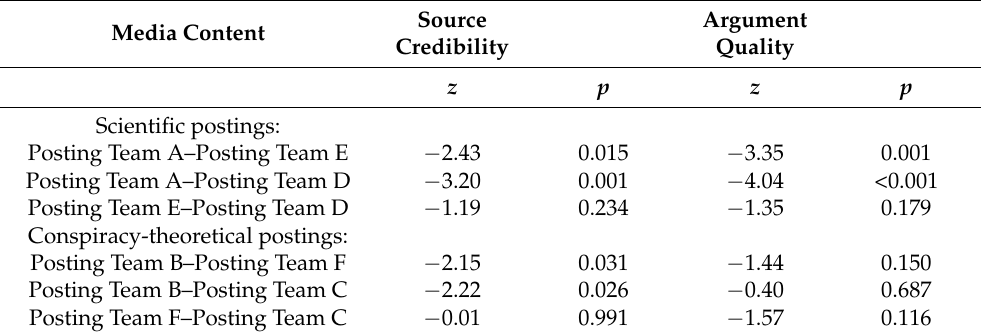
Table A2. Wilcoxon test for selection of the predictor variable media